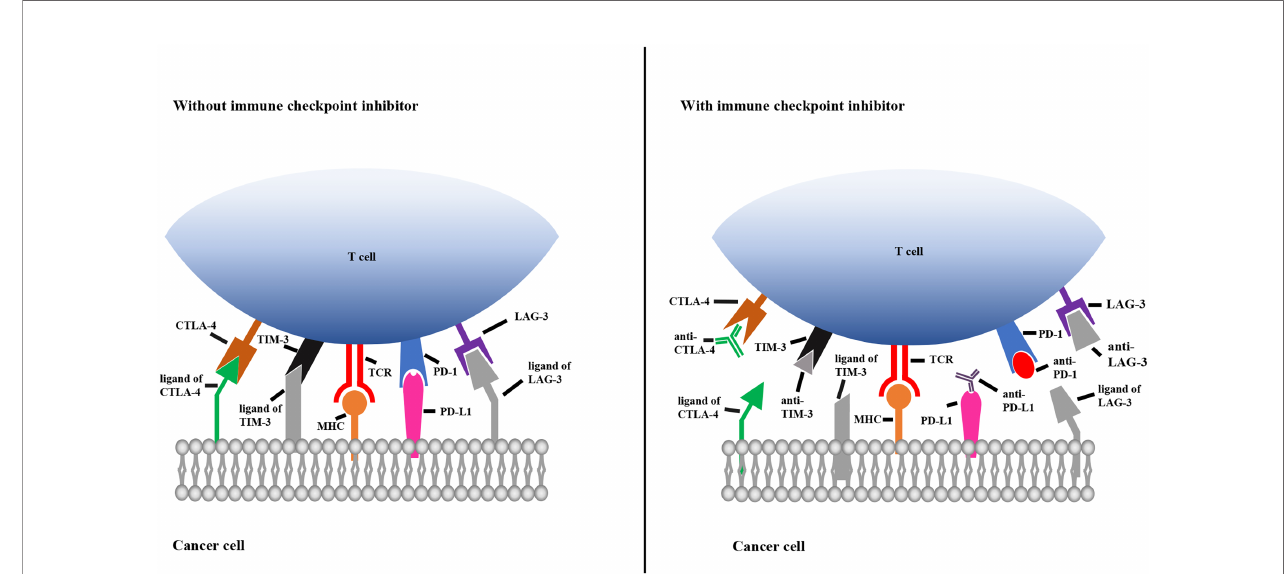
FIGURE 2 | Mechanisms of immune checkpoint inhibitors. The left picture shows that the immune checkpoint molecules on T cells combine with the corresponding ligands on cancer cells, resulting in immunosuppression of T cell. The right picture shows that immune checkpoint molecules bind to the corresponding antibody to prevent T cell death. TCR, T cell receptor; MHC, major histocompatibility complex; TIM-3, T cell immunoglobulin 3; CTLA-4, cytotoxic T-lymphocyte-associated protein 4; PD-1, programmed cell death 1; PD-L1, programmed cell death ligand 1; LAG-3, lymphocyte activation gene